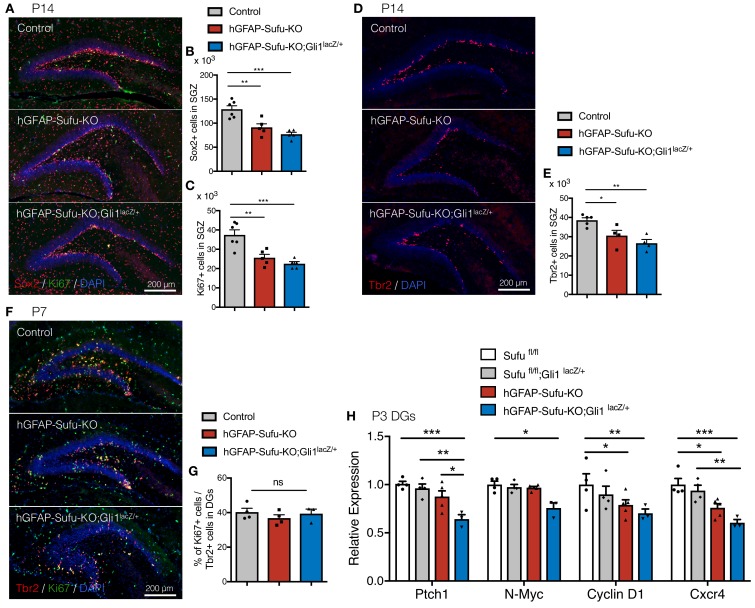
Deletion of Sufu decreases proliferation of NSCs, but not neuronal precursors.(A) Representative immunofluorescence images of Sox2 (red) and Ki67 (green) in the DG of Control, hGFAP-Sufu-KO and hGFAP-Sufu-KO;Gli1lacZ/+ mice at P14. DNA is stained with DAPI (blue). (B,C) Quantification of Sox2+ (B) and Ki67+ (C) cells in the SGZ [Control, n = 6; hGFAP-Sufu-KO, n = 5; hGFAP-Sufu-KO;Gli1lacZ/+, n = 5]. (D) Representative immunofluorescence images of Tbr2 (red) in the DG of Control, hGFAP-Sufu-KO and hGFAP-Sufu-KO;Gli1lacZ/+ mice at P14. (E) Tbr2 +cells counts in SGZ from each group [Control, n = 5; hGFAP-Sufu-KO, n = 4; hGFAP-Sufu-KO;Gli1lacZ/+, n = 4]. (F) Representative immunofluorescence images of Tbr2 (red) and Ki67 (green) in the DG of Control, hGFAP-Sufu-KO and hGFAP-Sufu-KO;Gli1lacZ/+ mice at P7. (G) The bar graph indicates the ratio of Ki67 +cells to Tbr2 +NSCs in DGs [Control, n = 4; hGFAP-Sufu-KO, n = 4; hGFAP-Sufu-KO;Gli1lacZ/+, n = 3]. (H) qRT-PCR analyses of Ptch1, N-Myc, Cyclin D1, and Cxcr4 expression in the DGs of Sufufl/fl, Sufufl/fl;Gli1lacZ/+, hGFAP-Sufu-KO and hGFAP-Sufu-KO;Gli1lacZ/+ mice at P3 [Sufufl/fl, n = 4; Sufufl/fl;Gli1lacZ/+, n = 4, hGFAP-Sufu-KO, n = 5; hGFAP-Sufu-KO;Gli1lacZ/+, n = 3]. Values represent mean ±SEM; ns: p>0.05, *p<0.05, **p<0.01, ***p<0.001. ANOVA with Tukey post-hoc tests.10.7554/eLife.42918.013Figure 3—figure supplement 2—source data 1.Extended numerical data and statistical analysis for Figure 3—figure supplement 2.